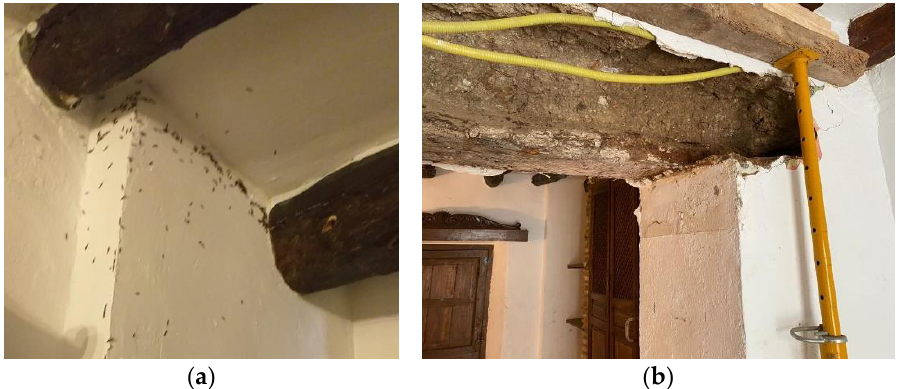
Figure 1. ( a ) Termite attack detected in a private home in Albuñuelas (Granada, Spain); ( b ) Inter- vention to replace damaged